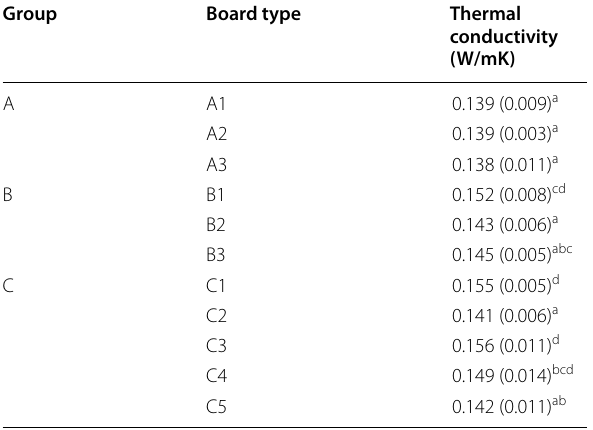
Table 6 Thermal conductivity of single layer TOCS-based